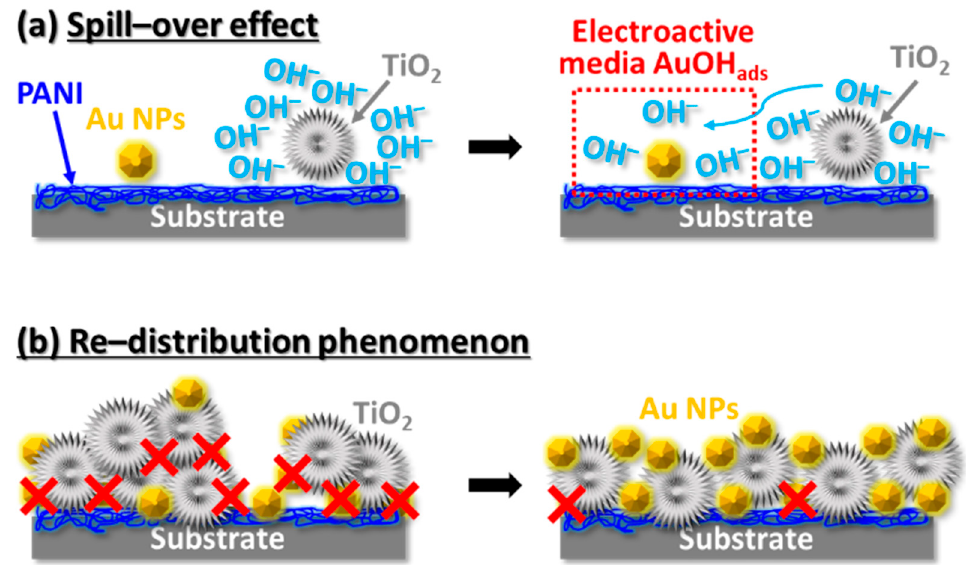
Figure 15. ( a ) Spill-over effect of the OH − from the TiO 2 particles to the Au NPs. ( b ) Redistribution phenomenon of the TiO 2 particles under its supersaturated concentration. (The red cross symbols indicate the unavailable electroactive sites due to the hindrance of the TiO 2 particles.).